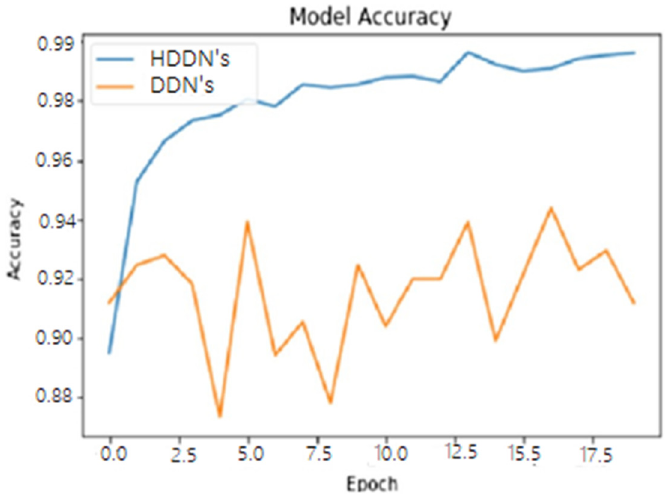
Figure 6. Accuracy of COVID-19 dataset against the number of COVID-19 CT and chest X-ray samples for the deep neural network (DNNs) and hybrid deep neural network (HDDNs).